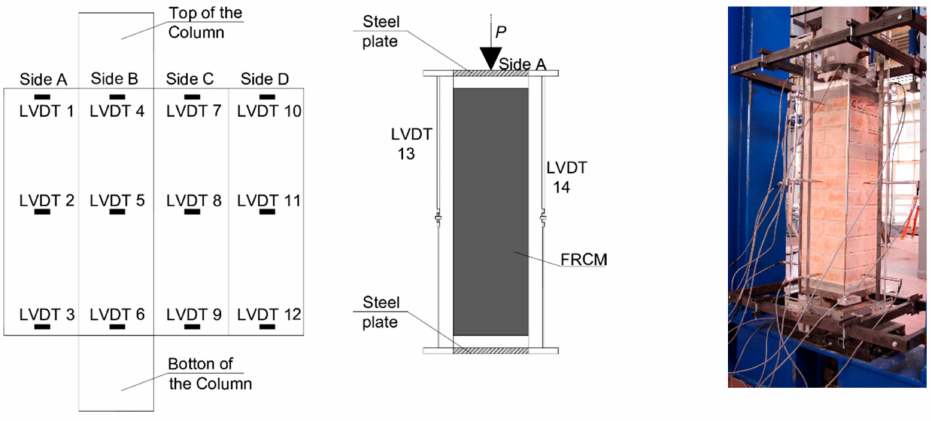
Figure 5. Test setup